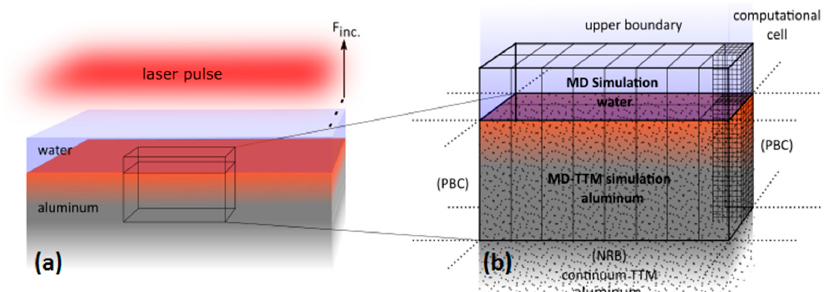
Figure 7. Computational box for simulations of laser formation of the Al NPs in water relays on the experimental geometry for the case of large laser spot size when the laser intensity across the computational cell can be considered uniform ( a ). The total computational cell is schematically represented for multiprocessing mode in ( b ). In each particular processor core, an atomistic-continuum molecular dynamics (MD)-two temperature model (TTM) for metal part and ordinary MD model for water part are solved in 3D space (internal mesh is shown for one processor core). Beneath the non-reflective boundaries (NRB), an ordinary TTM model is solved in continuum to account for the heat flux outward metal surface region describing the cooling process. By analogy, the NRB boundaries atop the water layer mimic the infinitely thick water layer, above which only mechanical properties of water are considered in